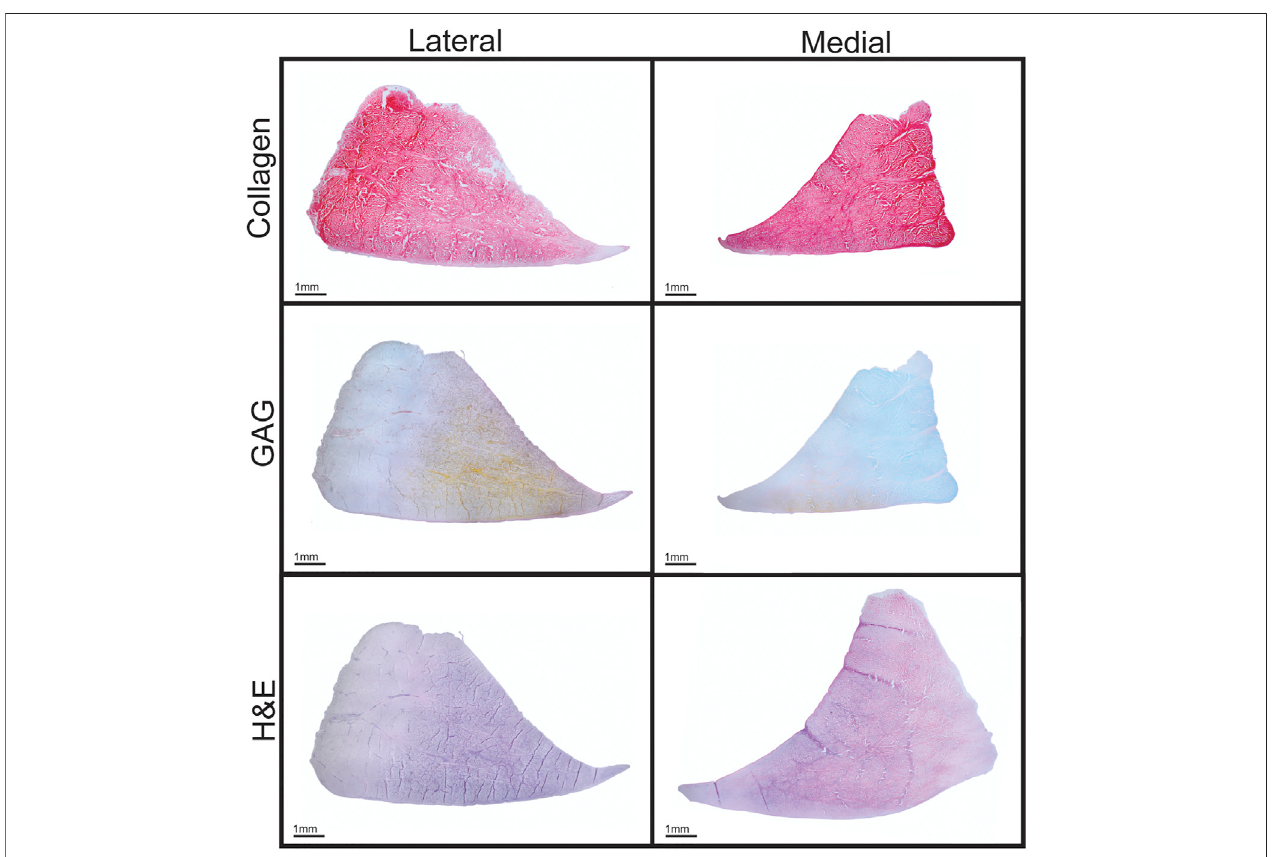
FIGURE 3 | Histological staining of Yucatan minipig knee menisci. Cross sections of menisci stained for collagen (picrosirius red), GAG (Safranin-O), and cell content (H&E) are shown.